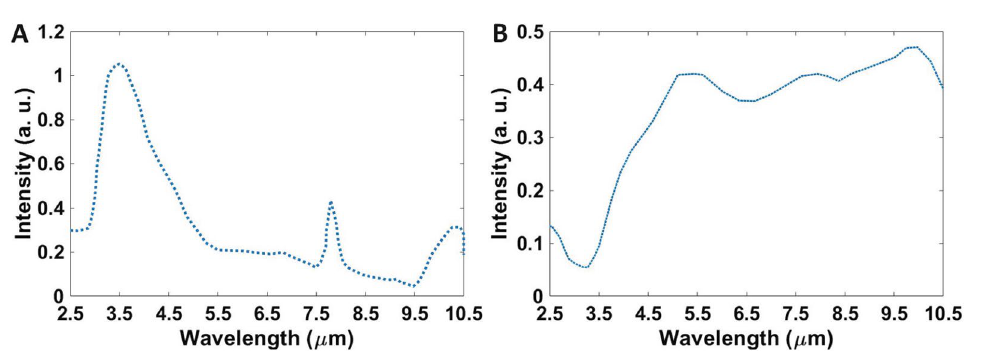
Figure 2. Absorption spectra of ( A ) PbSe, ( B ) epoxy